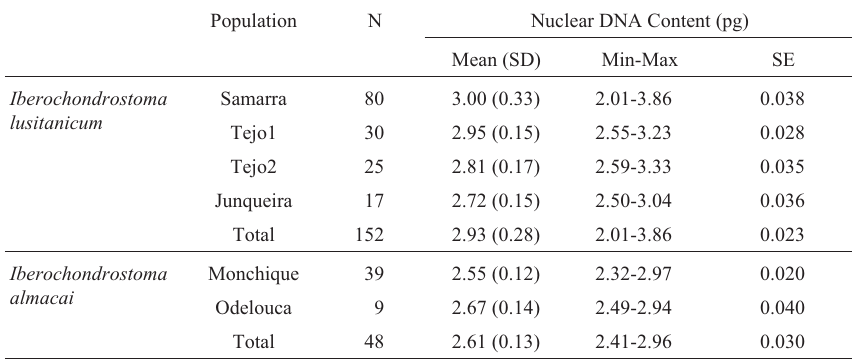
Table 3 - Statistics of the genome size data obtained by flow cytometry for the distinct populations of Iberochondrostoma almacai and I. lusitanicum (af- ter exclusion of the triploid